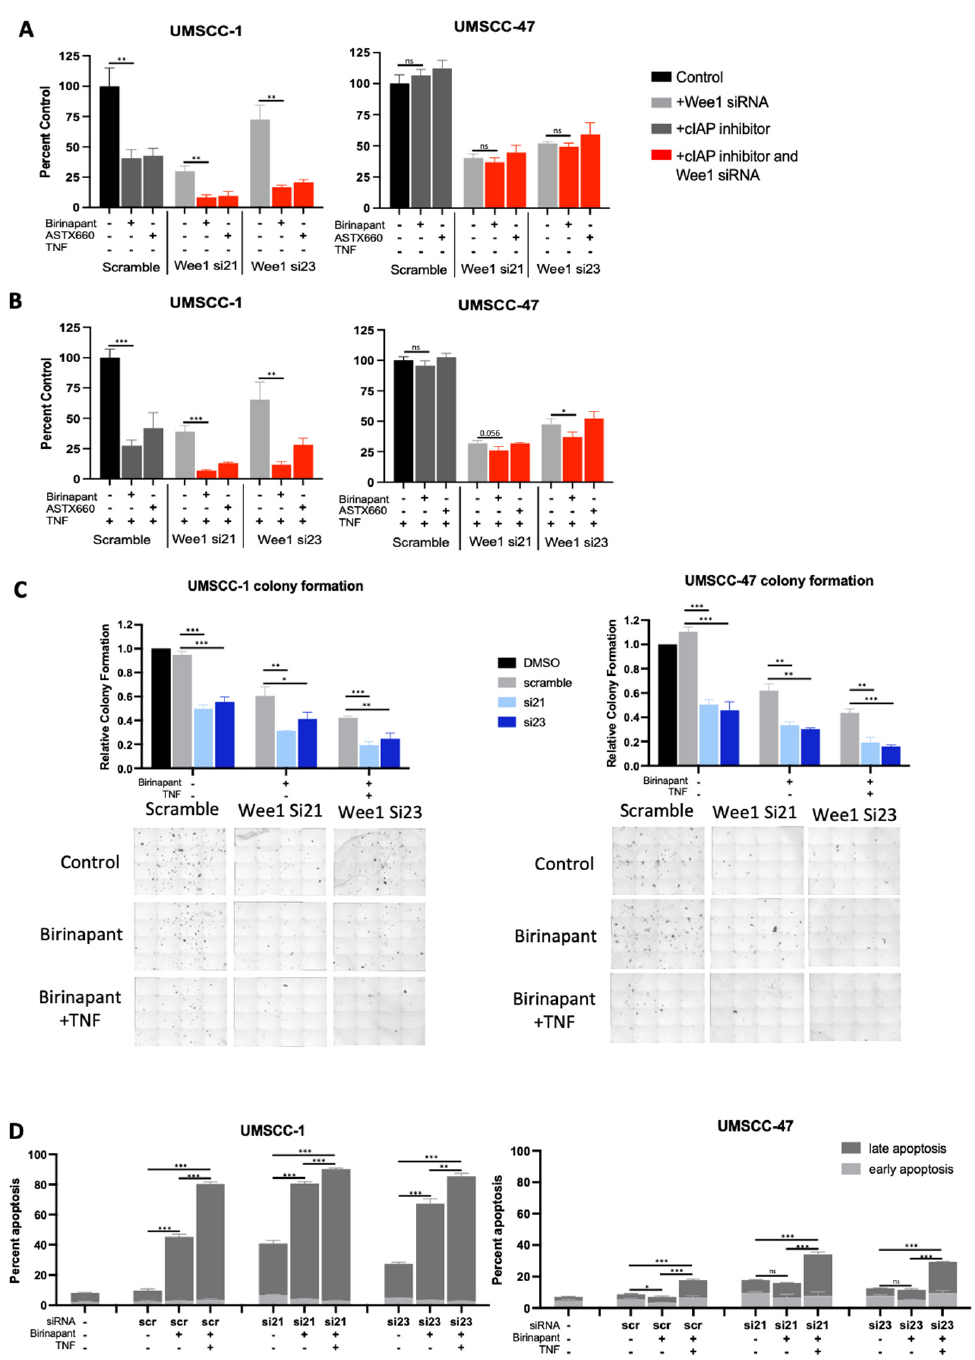
Figure 3. Alternative cIAP and WEE1 inhibition produce comparable effects in combination. XTT viability analysis of birinapant and ASTX660 in the presence of WEE1 siRNA (si21 and si23); AZD1775/ASTX660 = 500 nM, without TNF ( A ) and with TNF = 20 ng/mL ( B ). n = 3. ( C ) Colony